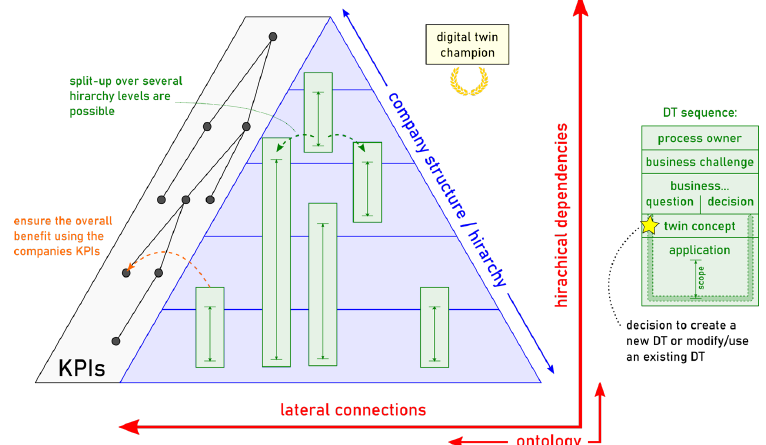
Figure 4. Hierarchical interplay between the different modeling